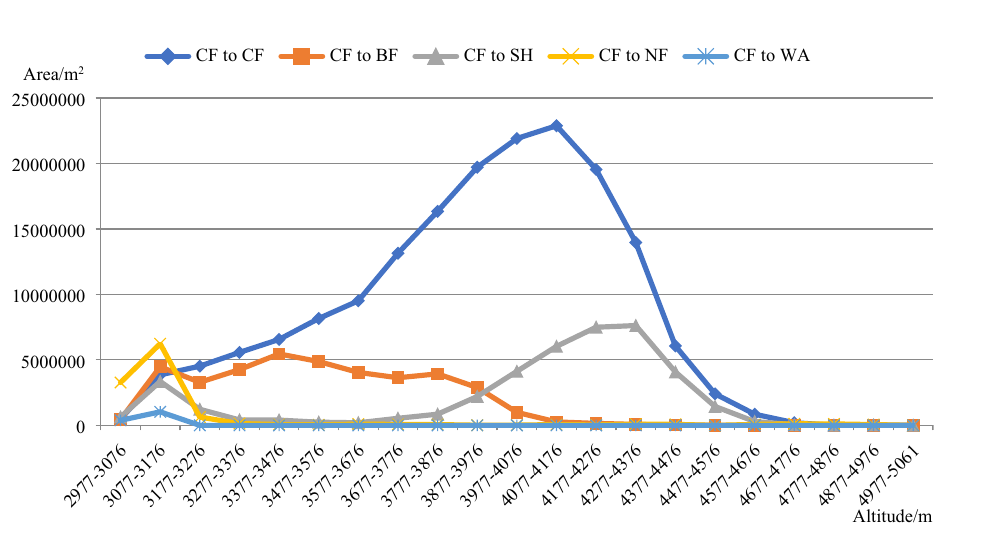
Figure 4. Distribution of the CF changes and the unchanged areas in the 21 altitude gradients between 2013 and 2015. The figure is generated using the Microsoft Office 2016 (http:// www. office.